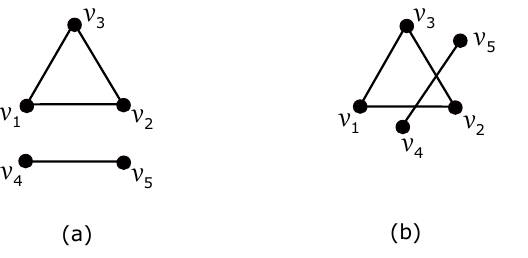
Figure 1. Two possible non isomorphic drawings of the graph G ∗ . ( a ): the planar drawing of G ∗ ; ( b ): the drawing of G ∗ with two crossings among